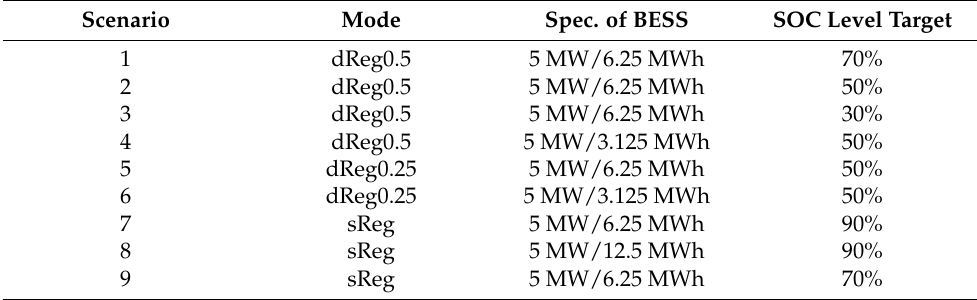
Table 2. Specification of simulation